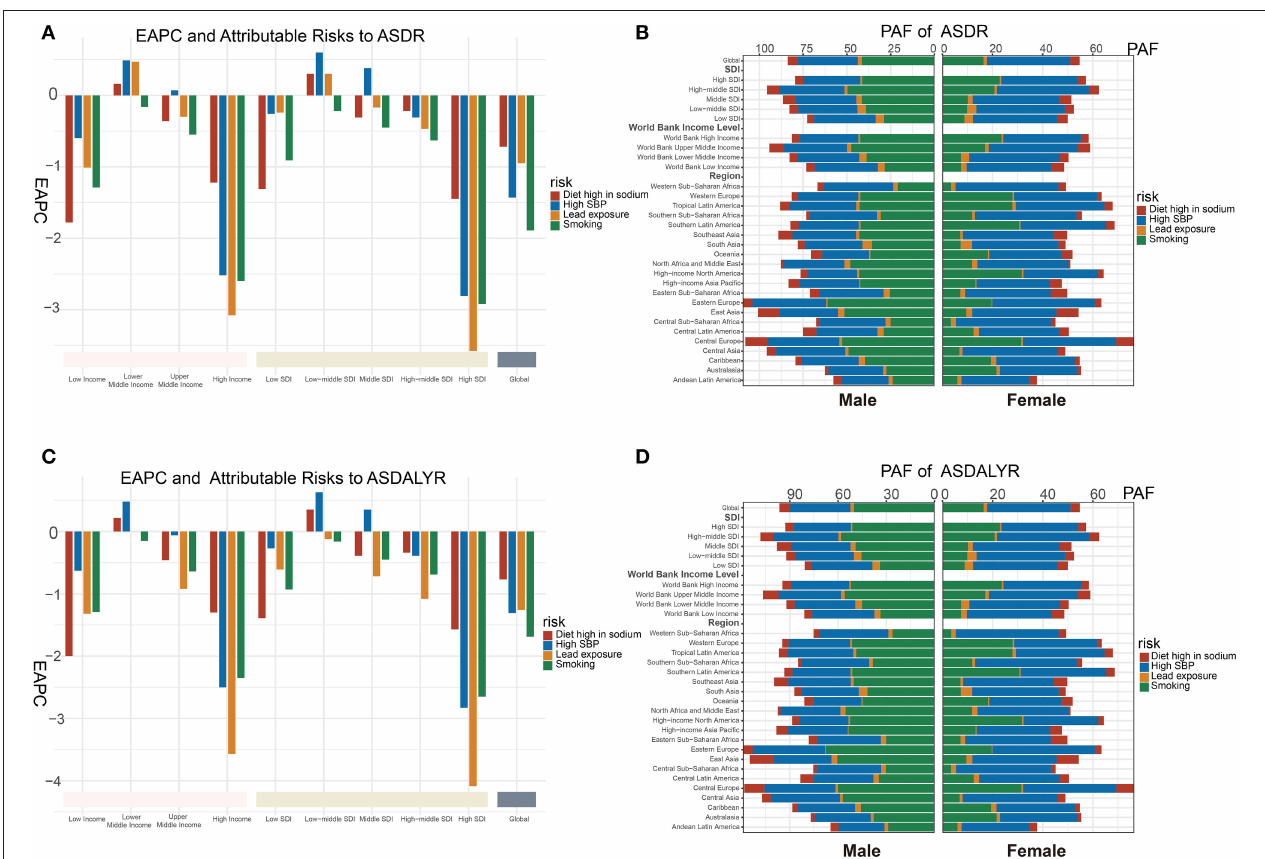
FIGURE 4 | Attributable risks of aortic aneurysm burden. (A) PAF of attributable risks of ASRD in 2019. (B) PAF of attributable risks of ASDALYR in 2019. (C) Global EAPC of attributable risks of ASRD with 30 regions. (D) Global EAPC of attributable risks of ASDALYR with 30 regions. PAF, population attributable fraction; ASRD, age-standardized death rate; ASDALYR, age-standardized DALY rate; EAPC, estimated annual percentage